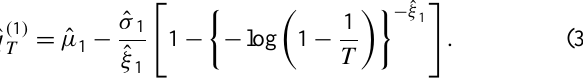
Fig. 3. Scatter plot of 100-year return levels estimated locally versus the return levels predicted by RS2. Pearsons correlation is 0.79.